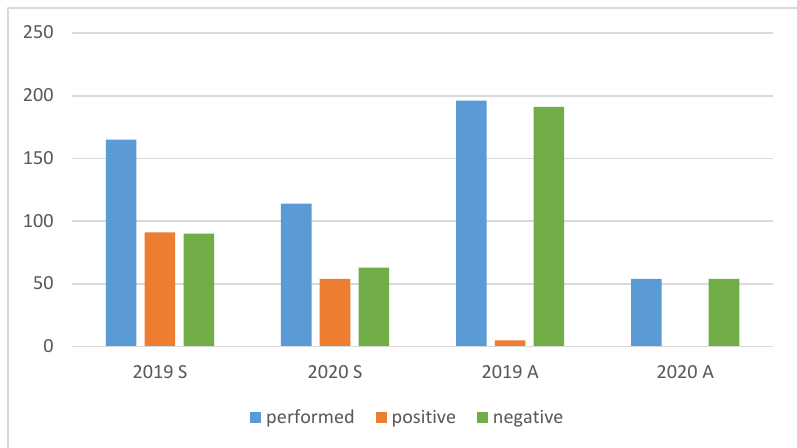
Figure 9. Comparison of RSV tests.